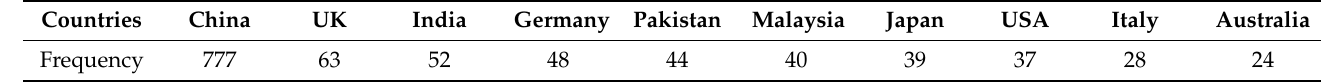
Table 4. Production frequency by countries.